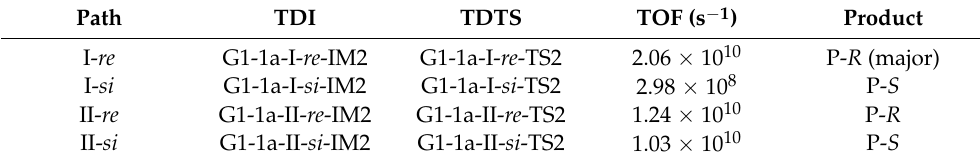
Table 1. Turnover frequency (TOF) of the catalytic cycle of aza-Henry reactions of isatin-derived ketimine (R1a) and nitromethane (R2) along four pathways. TDI and TDTS are the TOF-determining intermediates and TOF-determining transition states,